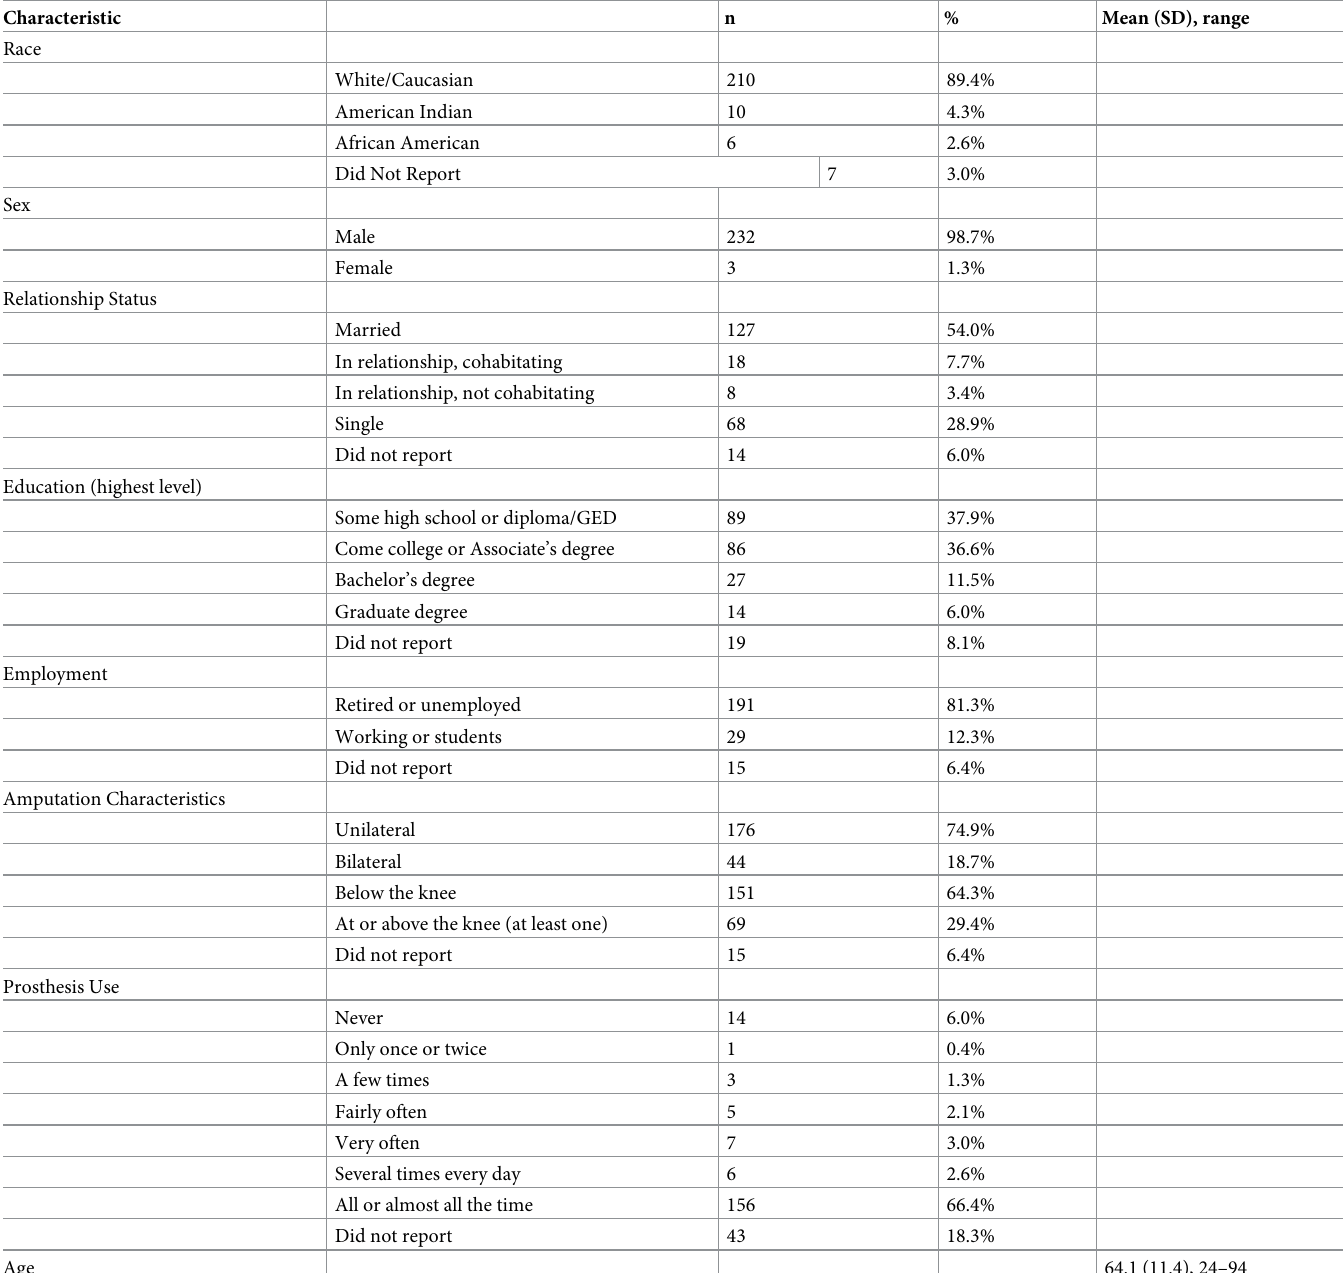
Table 1. Sample demographics (N =